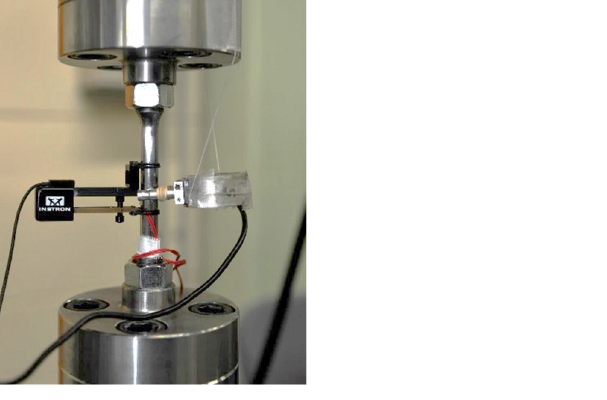
Figure 3. Detail of the equipment for measuring the strain and the specimen diameter.